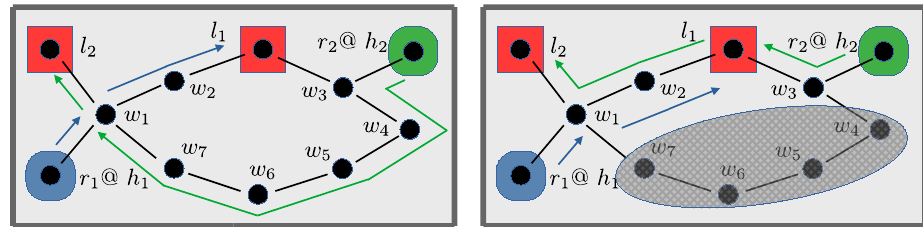
Figure 4. A simple example showing the limitation of the corridor-based routing; robot r 1 located at vertex h 1 needs to travel to l 1 , while robot r 2 at h 2 needs to travel to l 2 . For a uniform edge weight of 10 s the corridor-free encoding ( left ) can achieve the optimal makespan of 70 s by sending r 2 along a non-shortest path route, while the corridor-based encoding ( right ) rules out vertices w 4 , . . . , w 7 from the corridor and requires 80